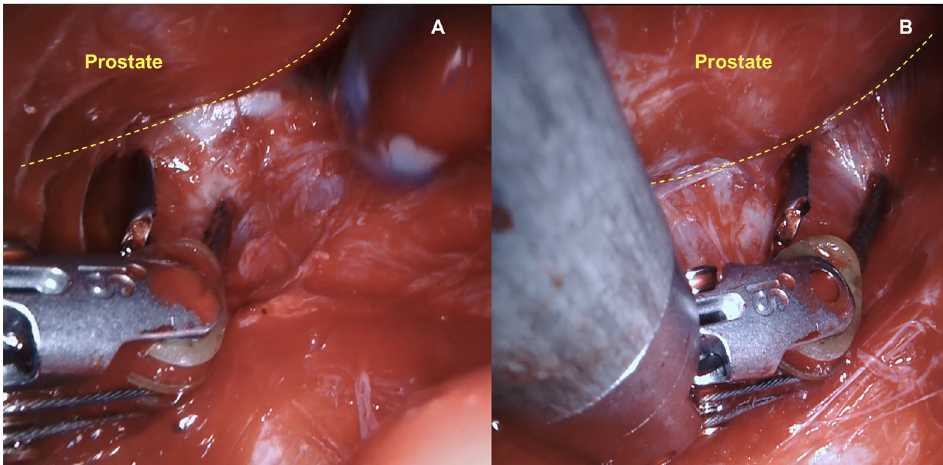
Figure 2 - Posterior prostatic dissection from 5 to 1 o’clock on the right side (B) and from 7 to 11 o’clock on the left side